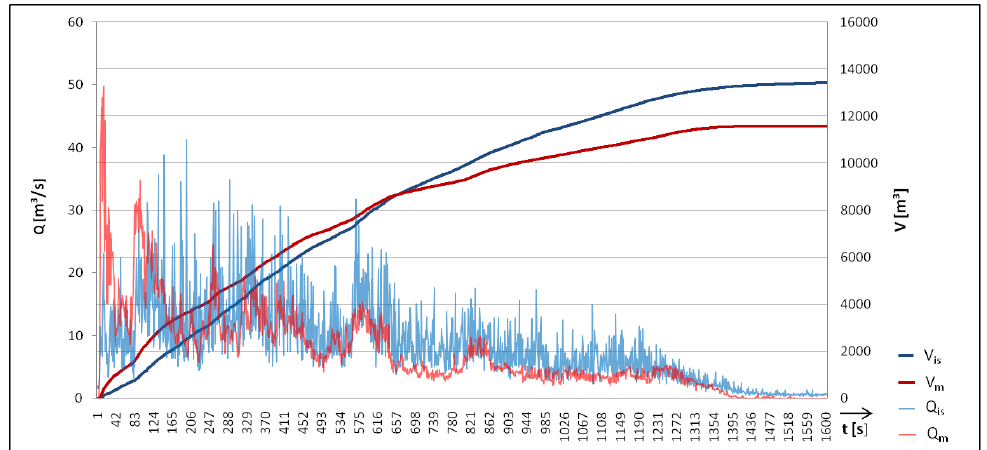
Figure 13. Calculated discharge (Q is ) and calculated volume (V is ) based on infrasound data compared to measured discharge (Q m ) and measured volume (V m ) of the debris flow at Lattenbach on 9 August